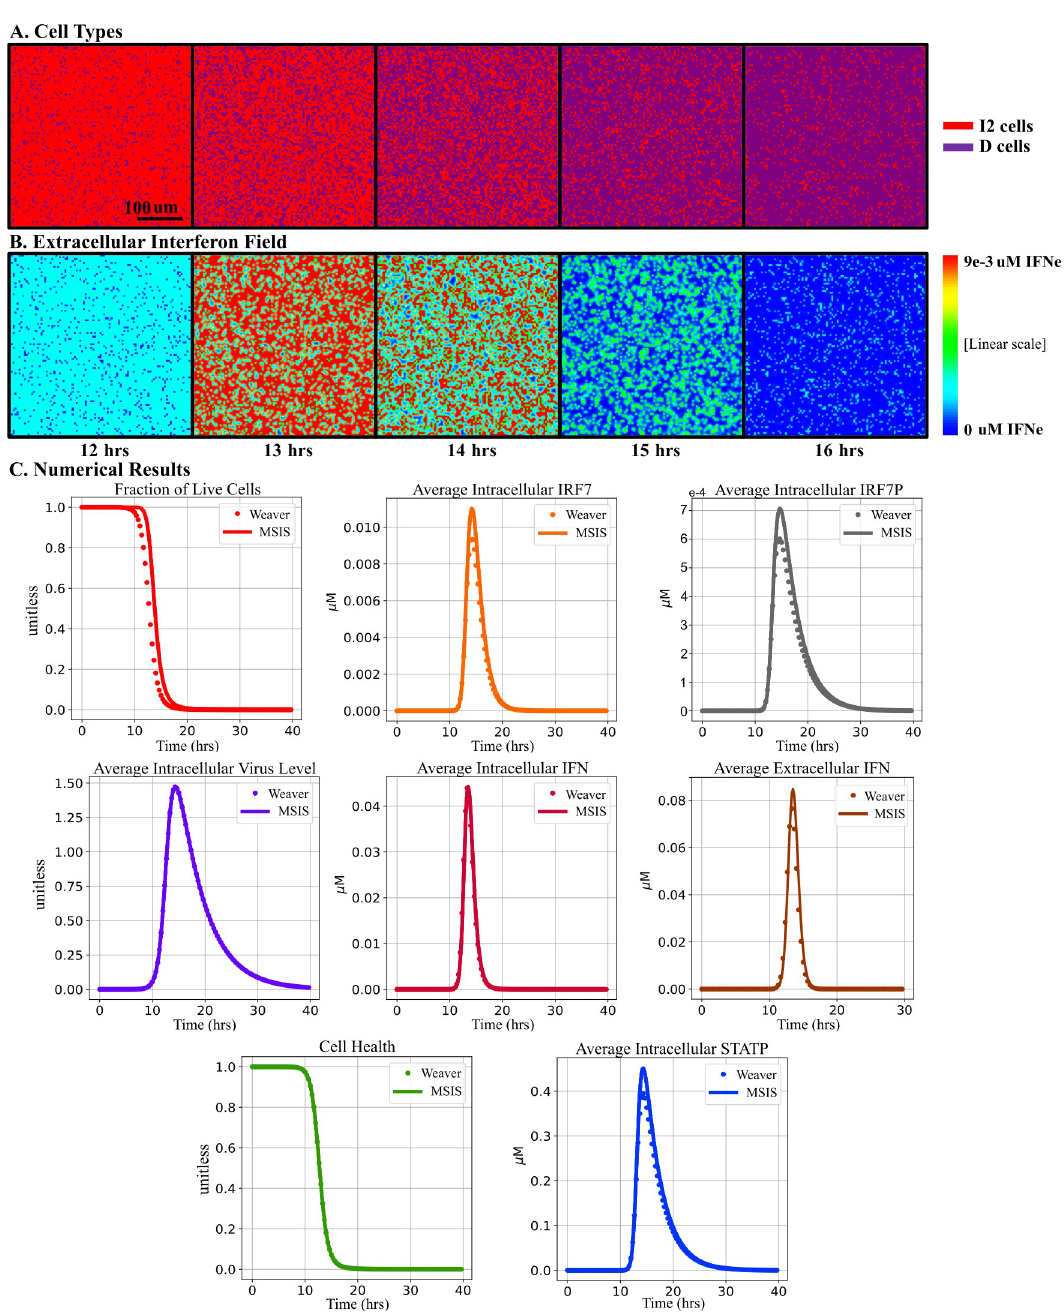
Fig 2. Comparison of time series for key variables between the multicellular spatial interferon signaling (MSIS) model and Weaver model for high MOI. All cells are initially infected with 6.9E-8 (unitless) virus, matching the original data to which the Weaver model was fit [49]. (A) Snapshots of the cell field showing cell type (virus releasing [I2] in red and dead [D] in purple) at different times in a representative MSIS simulation. (B) Snapshots of the concentrations of extracellular interferon (high concentrations in red, low concentrations in blue) at different times in a representative MSIS simulation. (C) Time series for key variables for the Weaver and MSIS models. MSIS simulations are averaged over 20 replicas at matching times (S1 Fig). Error bars are included but are too small to be visible. For the MSIS model, average concentrations for intracellular species and Health are calculated over all live (I2) cells at each time point while the Average Extracellular IFN for the MSIS model is the average of IFN e across the entire simulation